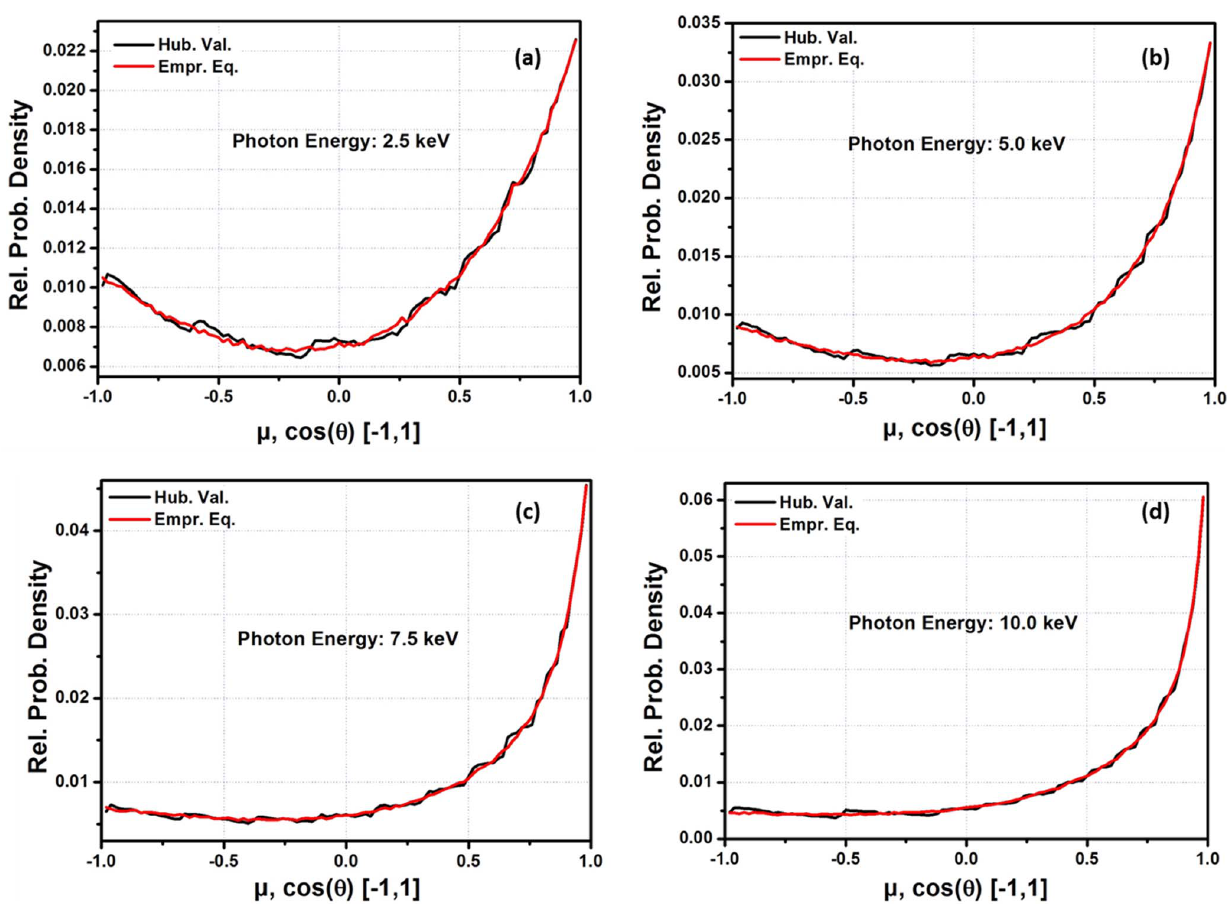
Figure 5. Angle distribution of coherently scattered photons for a source of 1 million photons by using F H ( q i , Z ) for ‘ q ’ from 0 to 16.0 A˚ 2 1 and Empirical equation data for Silicon (Si, Z=14) as a scatter element. (a) energy=0.0025 MeV, (b) energy=0.005 MeV, (c) energy=0.0075 MeV, (d) energy=0.01 MeV.